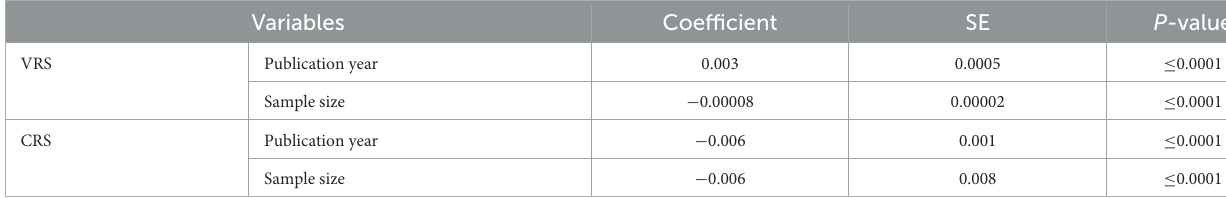
TABLE 4 Results of the heterogeneity test (meta-regression model).